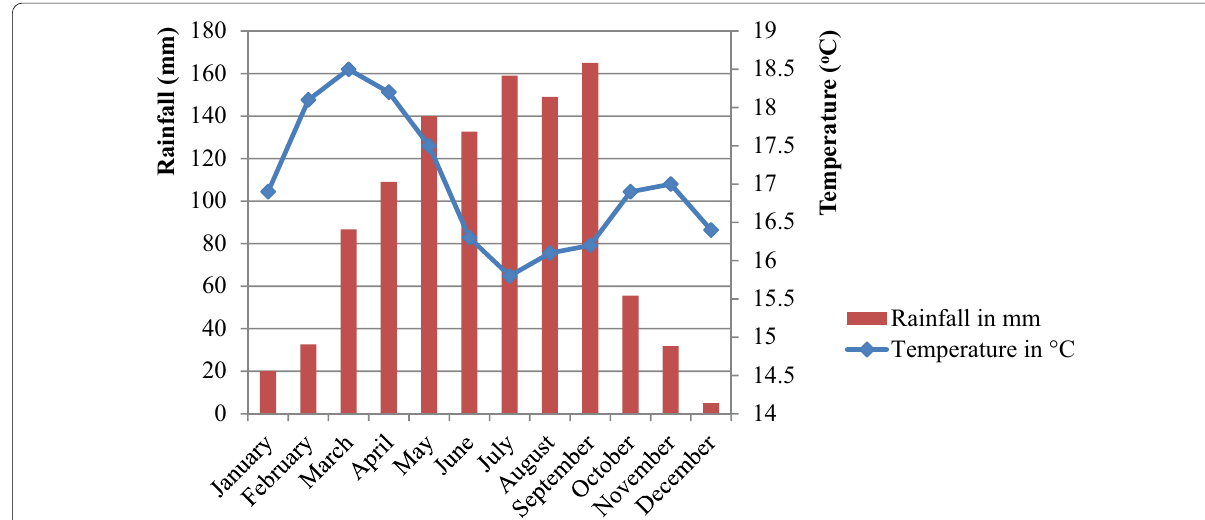
Fig. 2 Mean monthly rainfall and temperature of the study area (Ethiopian Metrological Service